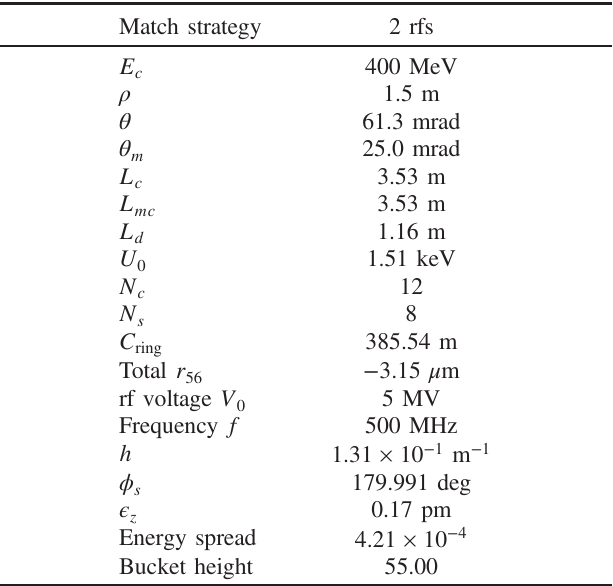
TABLE I. Parameters of a sample ultimate-longitudinal- emittance ring. Match strategy